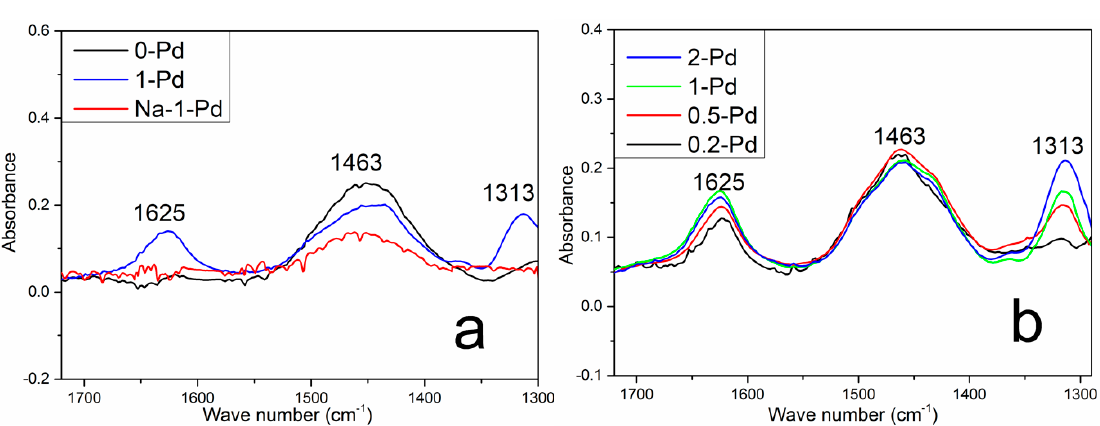
Figure 4. ( a ) NH 3 in situ FTIR spectra of 0-Pd, 1-Pd, Na-1-Pd; ( b ) NH 3 in situ FTIR spectra of 2-Pd, 1-